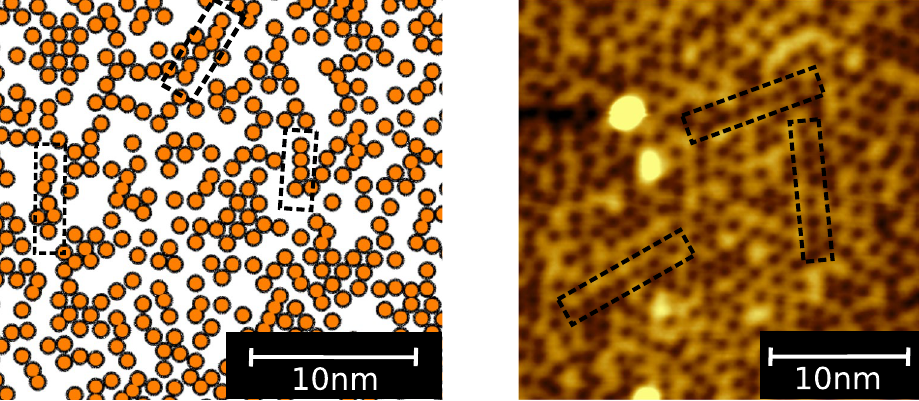
Figure 1. (Left) A snapshot of a Monte Carlo simulation at x = 0.0511 and T = 773 K. For clarity, only the Zn–Y clusters are shown. (Right) A typical STM image of the distribution of Zn–Y clusters in the stacking fault interface. Individual Zn–Y clusters are imaged as dark spots under positive bias voltage (empty-state image). In both images, chain-like arrangements of clusters are denoted by broken-line